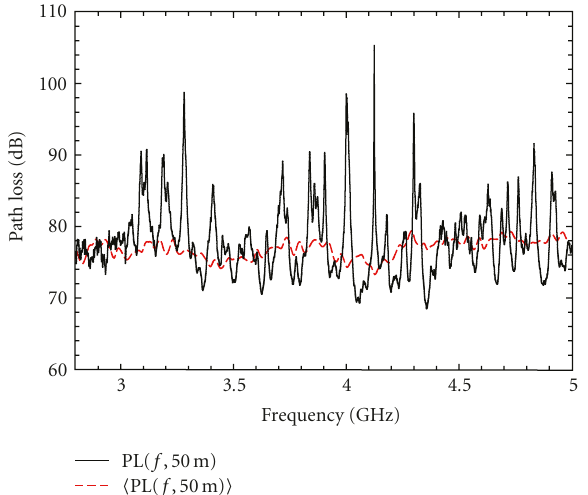
Figure 6: Axial correlation between receiving arrays 4 m (for 50m < d < 202 m) or 6 m (for 202m < d < 500m) apart for three frequencies and their corresponding